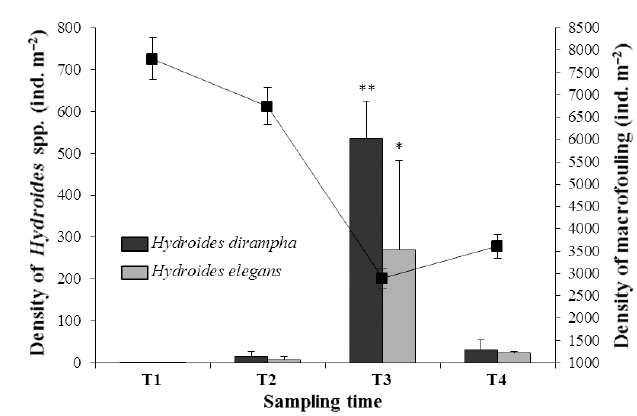
Fig. 5. Mean (±SE) densities of non-indigenous Hydroides spp. (bars) and of other macrofouling species (black squares) at different sampling times (see Fig. 1). Significant highest values of density were reported for the 2 serpulids at T3. *p < 0.05, **p <